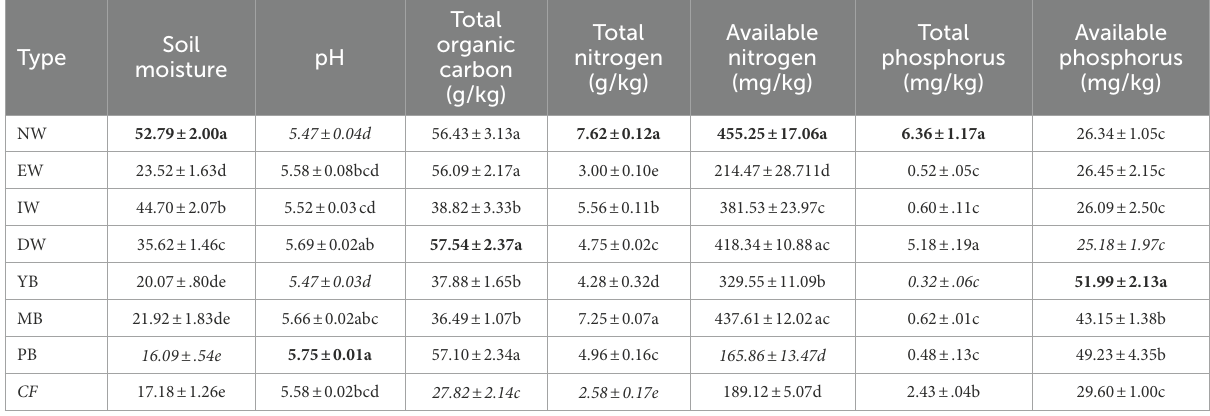
TABLE 1 Soil physicochemical properties and soil enzymes in the eight vegetation types along a successional gradient in a degraded wetland.